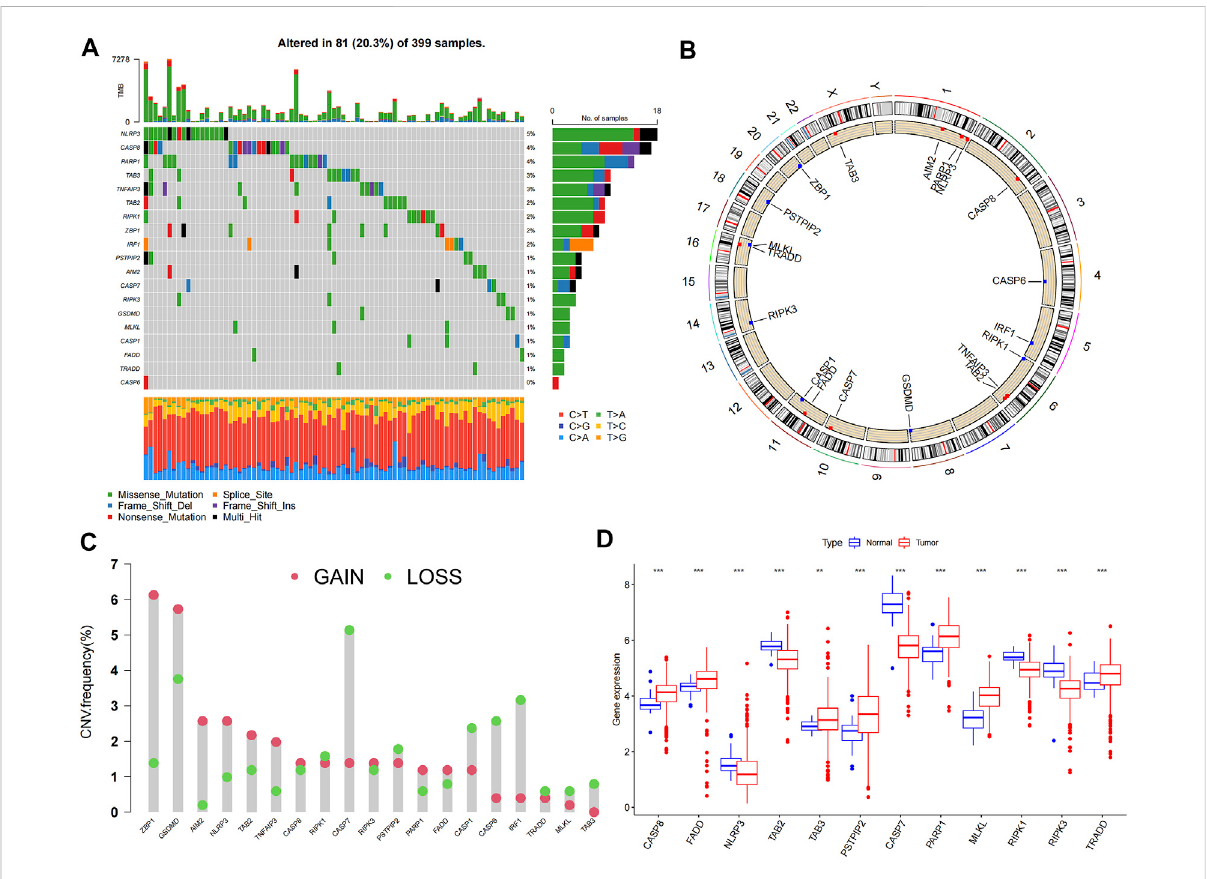
FIGURE 1 Genetic and transcriptional alterations of 19 PRGs in colon cancer. (A) Mutation frequencies of 19 PRGs in colon cancer patients from TCGA cohort; (B) LocationsofCNValterations inPRGson23chromosomes; (C) FrequenciesofCNVgain,loss,andnon-CNVamongPRGs; (D) Expression levels of PRGs between normal and tumor samples. ** p < 0.01; *** p <